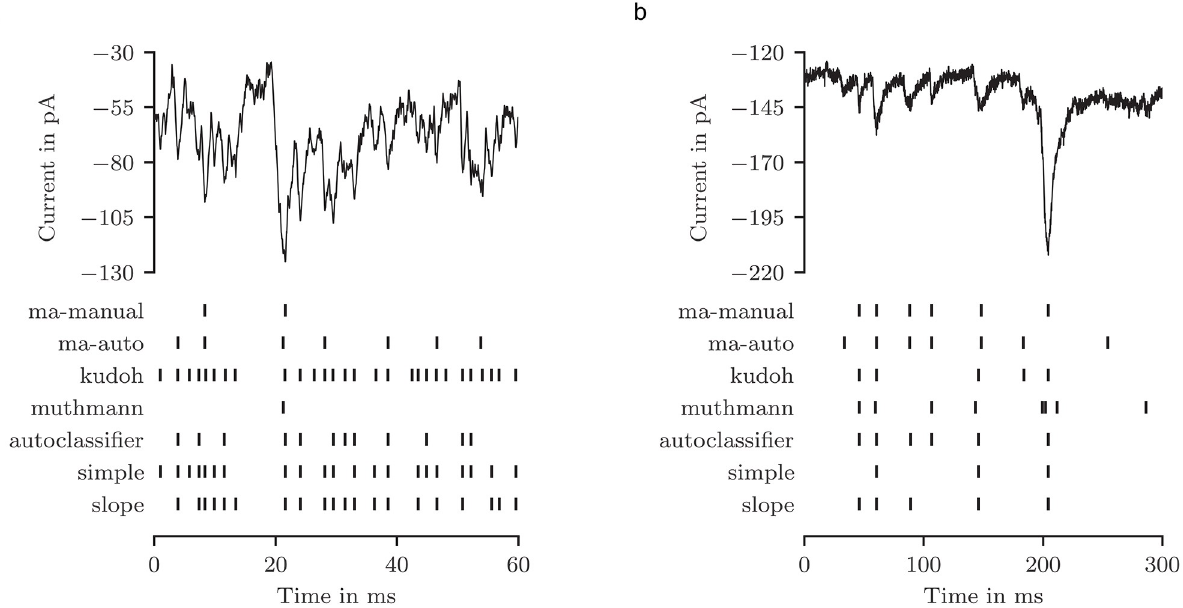
Fig 2. Representative time series of spontaneous synaptic activity measured in (a) a retinal horizontal cell and (b) a cultured cortical neuron (upper panel), and peak positions of events detected by the algorithms specified on the left (lower panel). “ma-manual” and “ma-auto” were carried out with the MiniAnalysis software package, “kudoh” refers to the multi-step threshold algorithm of [16], and “muthmann” to the MEA software package [17]. “autoclassifer”, “simple” and “slope” are novel algorithms described in the main text.